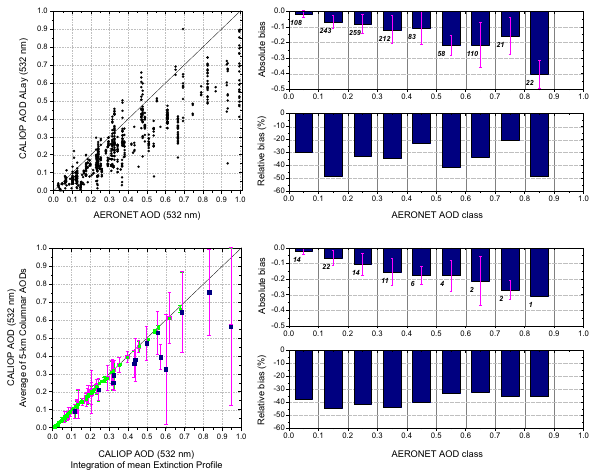
Fig. 1. Upper: scatter plot comparison of CALIPSO 5km dust AOD versus collocated AERONET measurements (left), absolute and rel- ative biases per AERONET AOD class (right). Lower: comparison of CALIPSO scene averaged dust AOD using different methodolo- gies (left), absolute and relative biases per AERONET AOD class